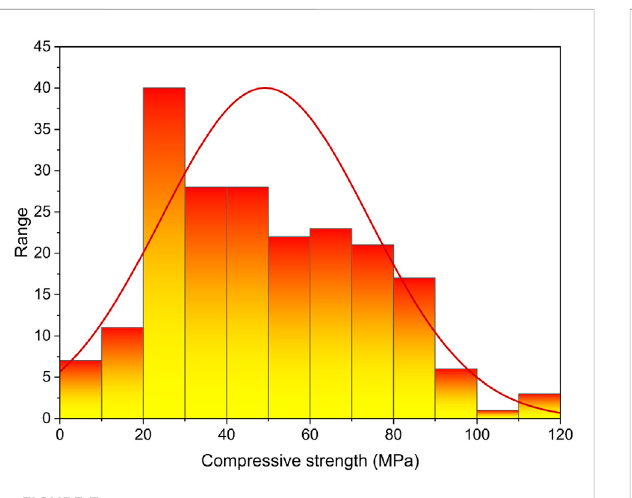
FIGURE 7 Distribution of the compressive strength of HSC.